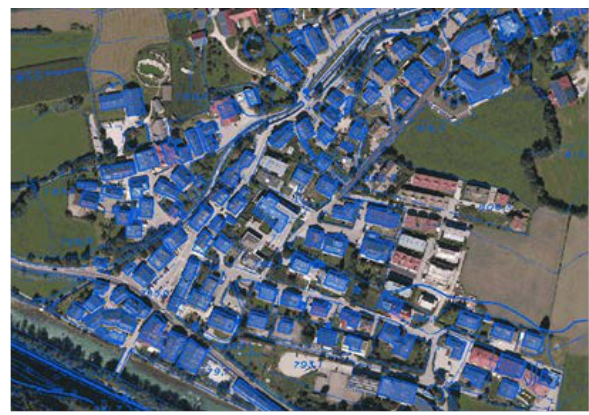
Figure 4. Overlay of the orthophotos corresponding to 1986 data set and the regional raster map at scale 1:5,000, after horizontal shift refinement.